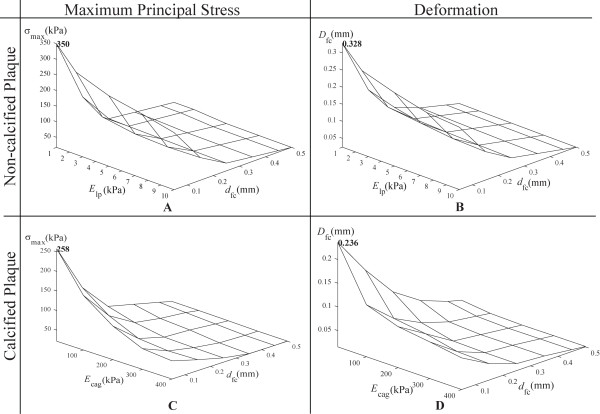
Maximum principal stress and deformation based on elasticity of three-dimensional plaque composite and fibrous cap thickness based on non-calcified and calcified plaque. A: For a three-dimensional non-calcified plaque, graph of the maximum principal stress σmax versus Young modulus Elp and fibrous cap thickness dfc shows that critical stress is 350 kPa. B: For a three-dimensional calcified plaque at dcg = 0.02 mm, the plot of σmax versus Ecag and dfc shows that critical stress is 258 kPa. C: For a three-dimensional non-calcified plaque, graph of peak deformation Dfc versus Elp and dfc shows that maximum deformation Dmax is 0.328 mm. D: For a three-dimensional calcified plaque, graph of Dfc versus Ecag and dfc gives Dmax = 0.236 mm.